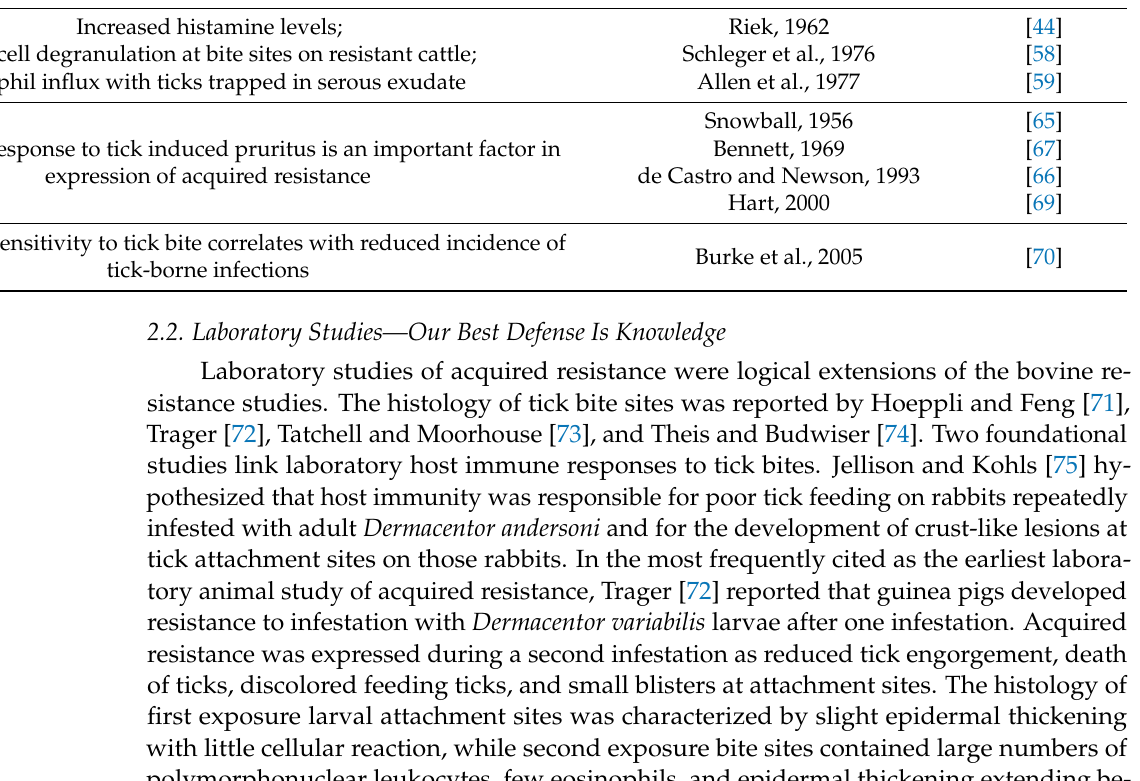
Table 2. Cutaneous hypersensitivity and host grooming response to reduce tick infestation. Cutaneous Hypersensitivity Induced Grooming Response Observations Bovine acquired resistance cutaneous hypersensitivity associated with exudate that traps ticks, bite site vesicles, poorly fed and dead